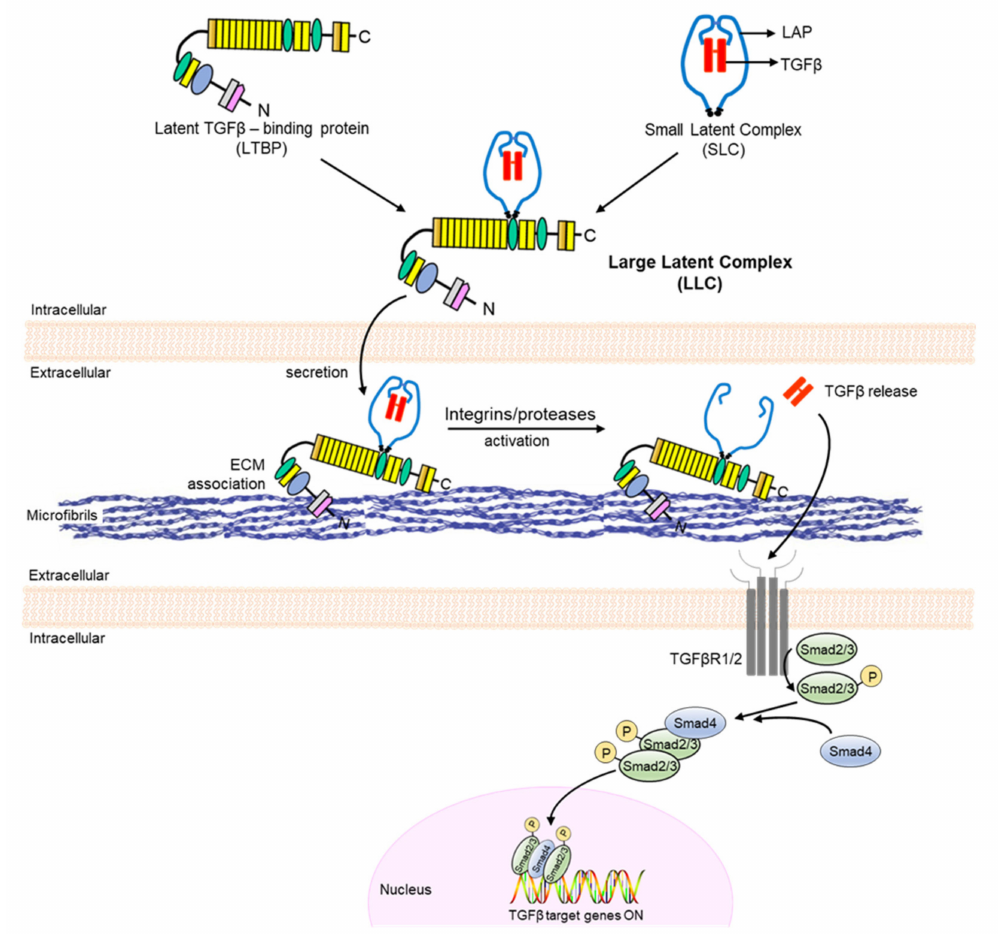
Figure 2. TGF β latent complex, activation, and signaling. TGF β is produced in the small latent complex that binds intracellularly with a latent TGF β -binding protein to form the large latent complex, which associates extracellularly with fibrillin-1 microfibrils. After integrin/protease-mediated activation and release, TGF β signals through receptor-mediated activation of the canonical Smad2/3